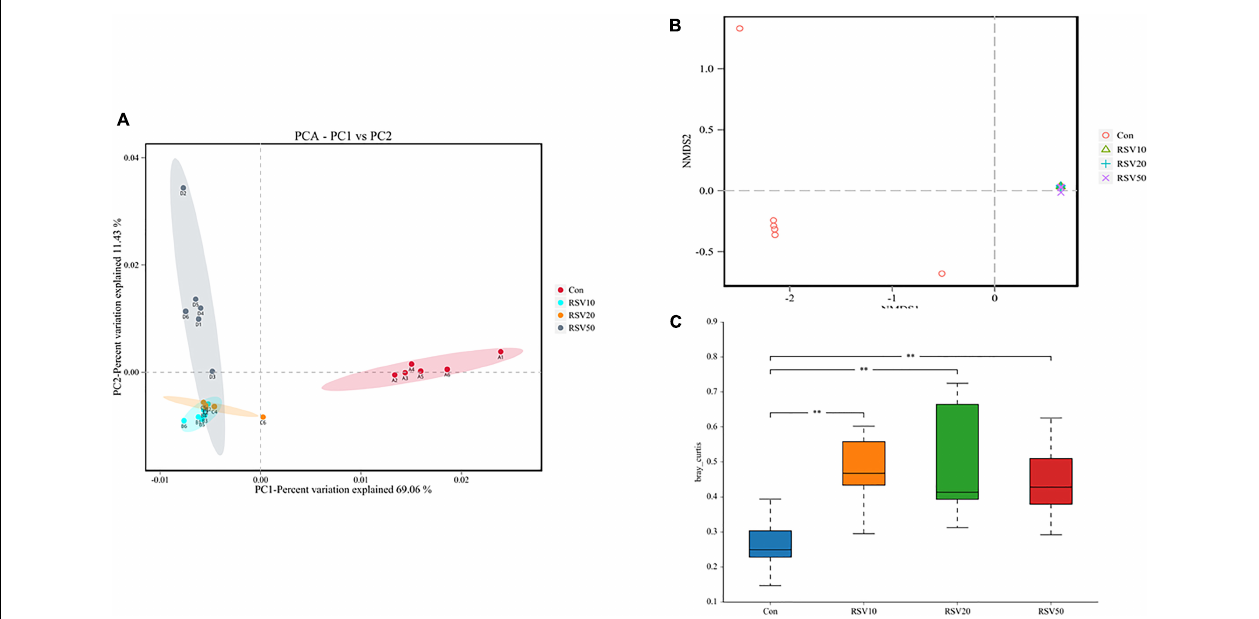
FIGURE 7 | Effect of RSV on Beta diversity indices of bacterial communities in the cecum content of weaned mice. (A) The principal component analysis (PCA) and (B) nonmetric multidimensional scaling (NMDS) plots were used to analyze bacterial communities. (C) Weighted Unifrac analysis was used to measure β -diversity. Con = control group, RSV10 = 10 mg/kg RSV, RSV20 = 20 mg/kg RSV, RSV50 = 50 mg/kg RSV. **Means with double asterisks are extremely significant different ( p < 0.01) from values of control group.